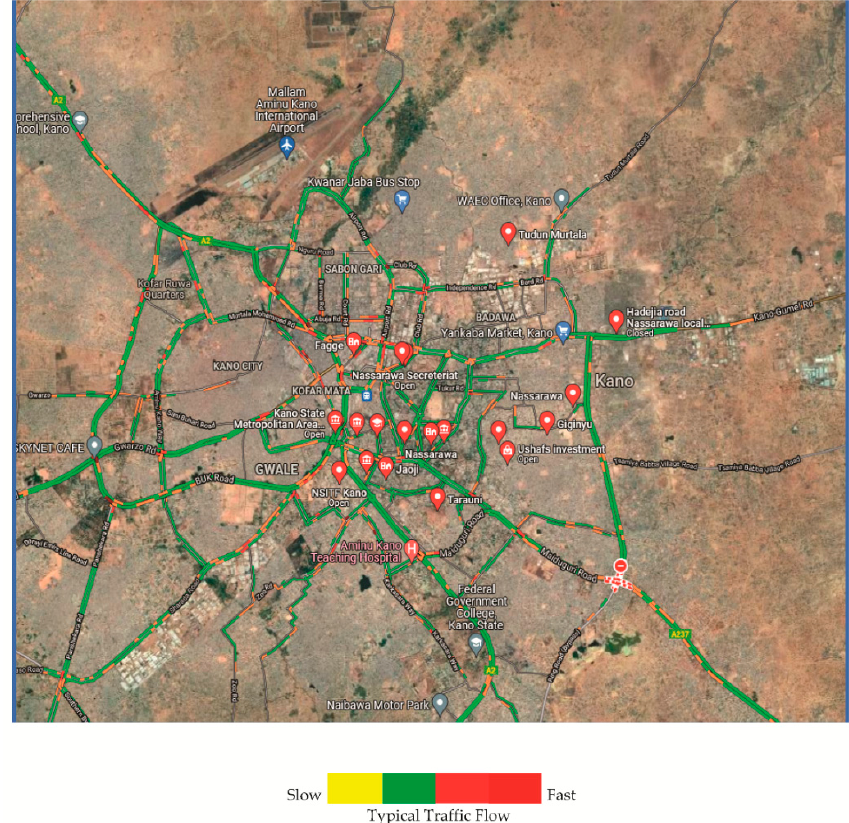
Figure A2. Map of Nigeria highlighting Kano State and satellite image of Kumbotso Local Government Areas showing typical week day traffic (Source: Google maps ® ).